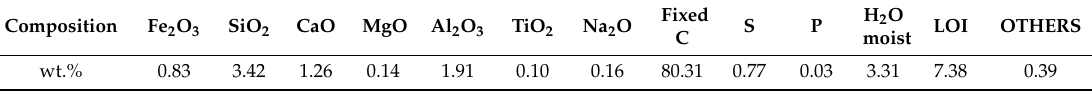
Table 2. Metallurgical coke chemical analysis. Fixed C: fixed carbon, LOI: loss of ignition. Composition Fe 2 O 3 SiO 2 CaO MgO Al 2 O 3 TiO 2 Na 2 O